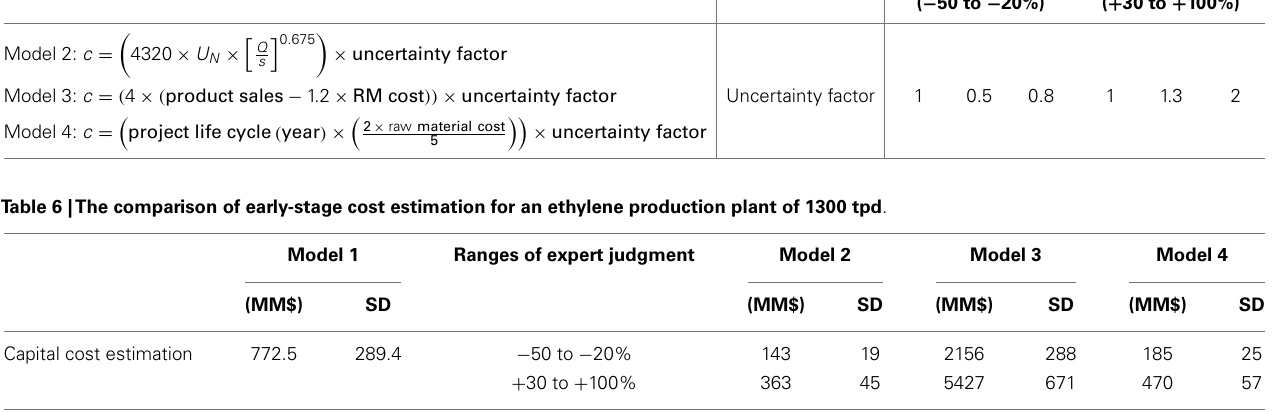
Table 5 |The input parameters for three cost estimation models . Model